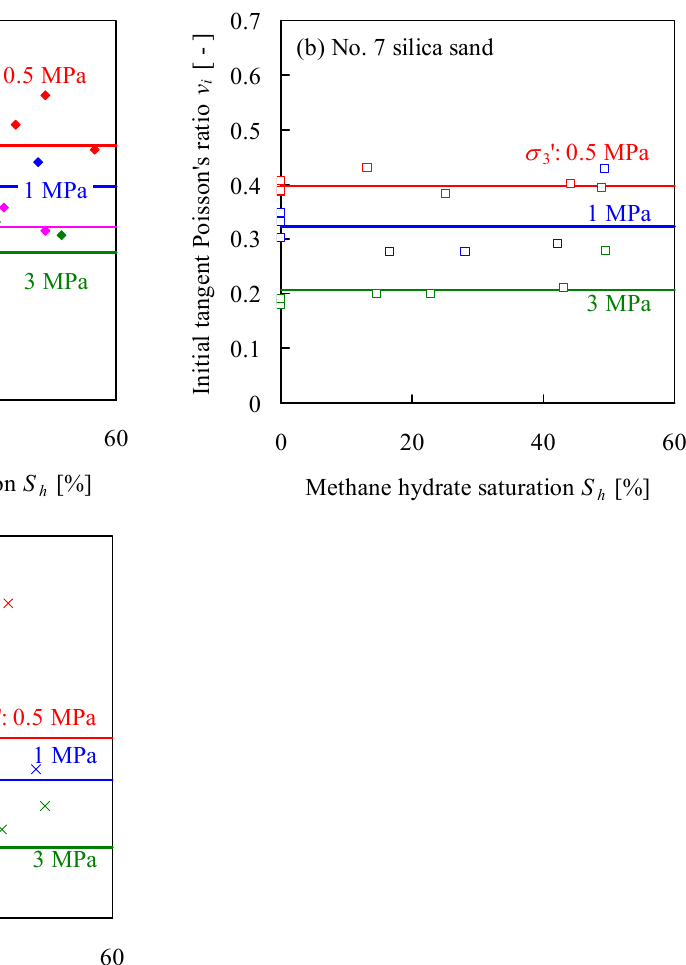
Figure 11. Initial tangent Poisson’s ratio υ specimens formed by ( a ) Toyoura sand; ( b ) No.7 silica sand and ( c ) No.8 silica sand.